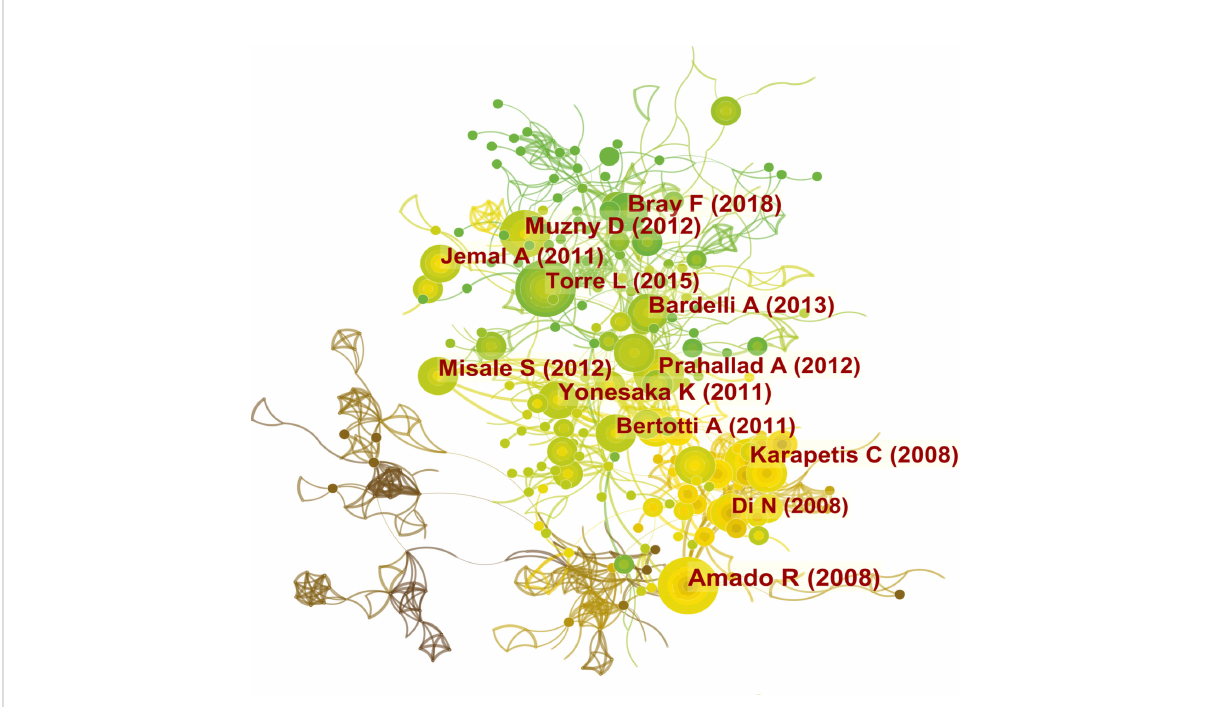
FIGURE 7 Network visualization diagram of cited references. Cited references are indicated by the node. The nodes represent cited references, and the lines mean citations between them. The citation number is proportional to the size of nodes, and the thickness of the connecting line is proportional to the degree of citations. From 2002 to 2021, the color changed from yellow to green.